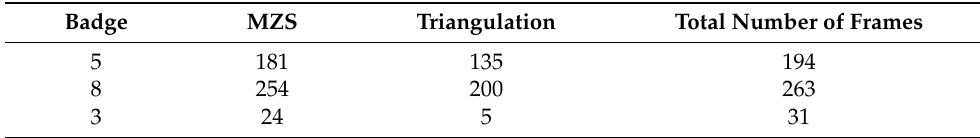
Table 5. Number of frames processed by MZS and the